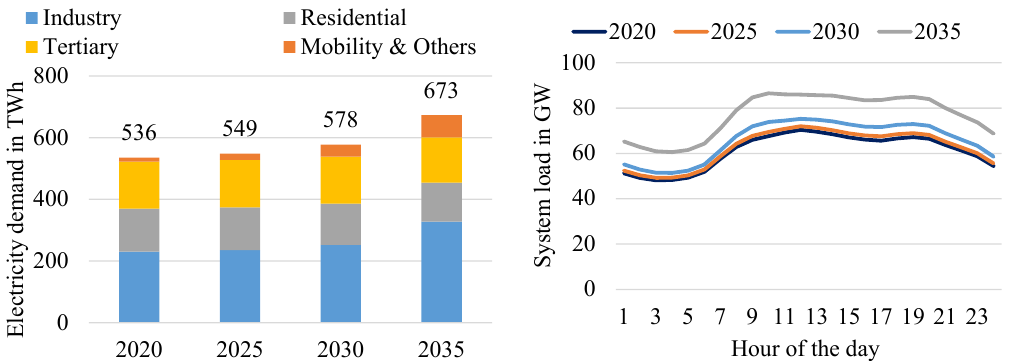
Figure 4. Annual electricity demand development in Germany by sector ( left ) and average hourly electricity demand over the course of a day ( right